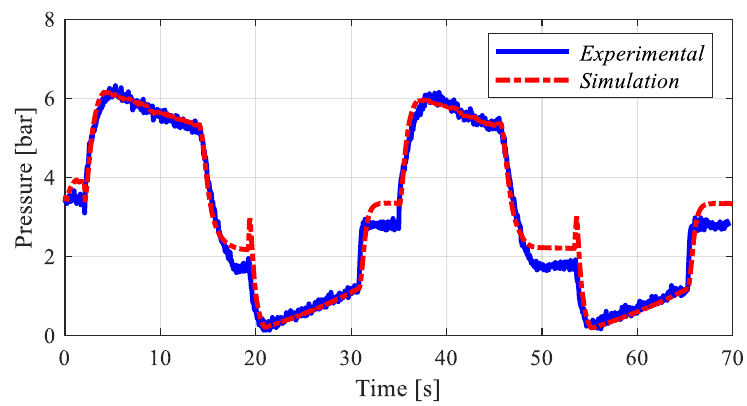
Figure 7. Piston rod side chamber pressure.